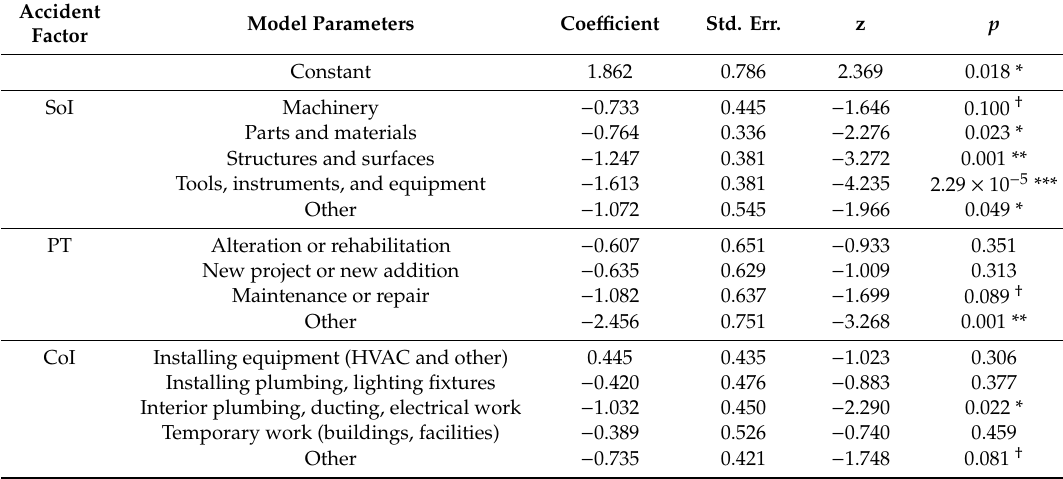
Table 11. Final model for the electrical contractors (number of remaining accidents =